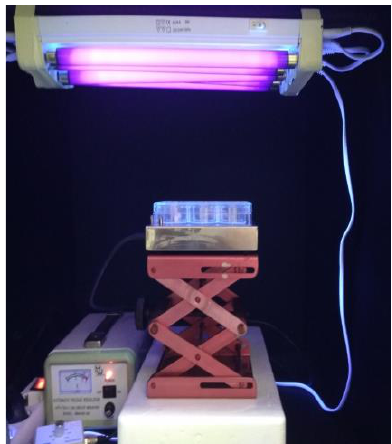
Figure 2. Configuration of the photocatalytic set-up. The photograph depicts the bench-scale photocatalytic reactor used in this study. UV-A lamps connected to a voltage stabilizer and emitting at a peak of 365 nm were used as a source of irradiation. Photocatalysis was performed in 6-well plates placed at a distance of 10 cm from the light source. A magnetic stirrer was used to ensure constant stirring of the treated